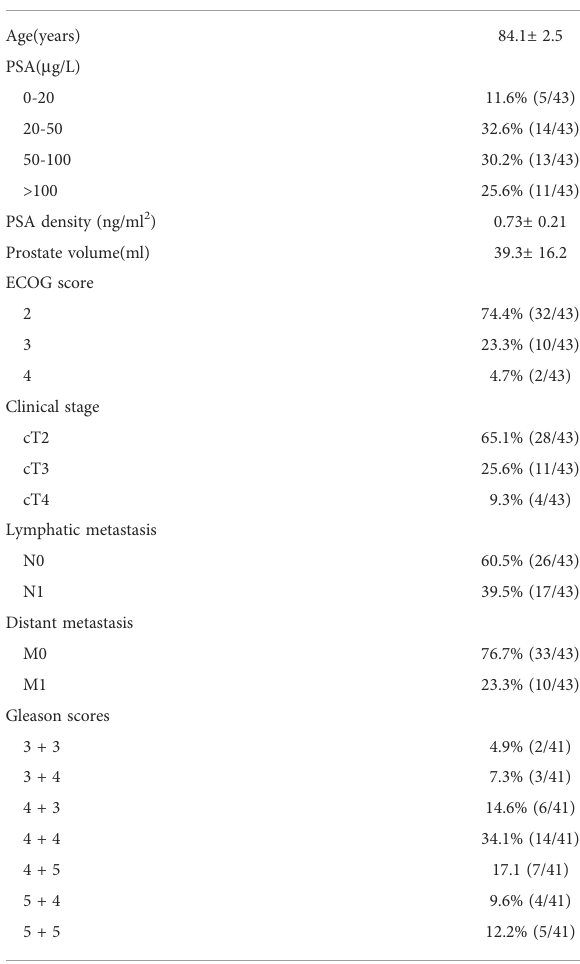
TABLE 1 The characteristics of patients 80 or greater years of age with PIRADS 5 lesions and high suspicion for clinically signi fi cant prostate cancer.